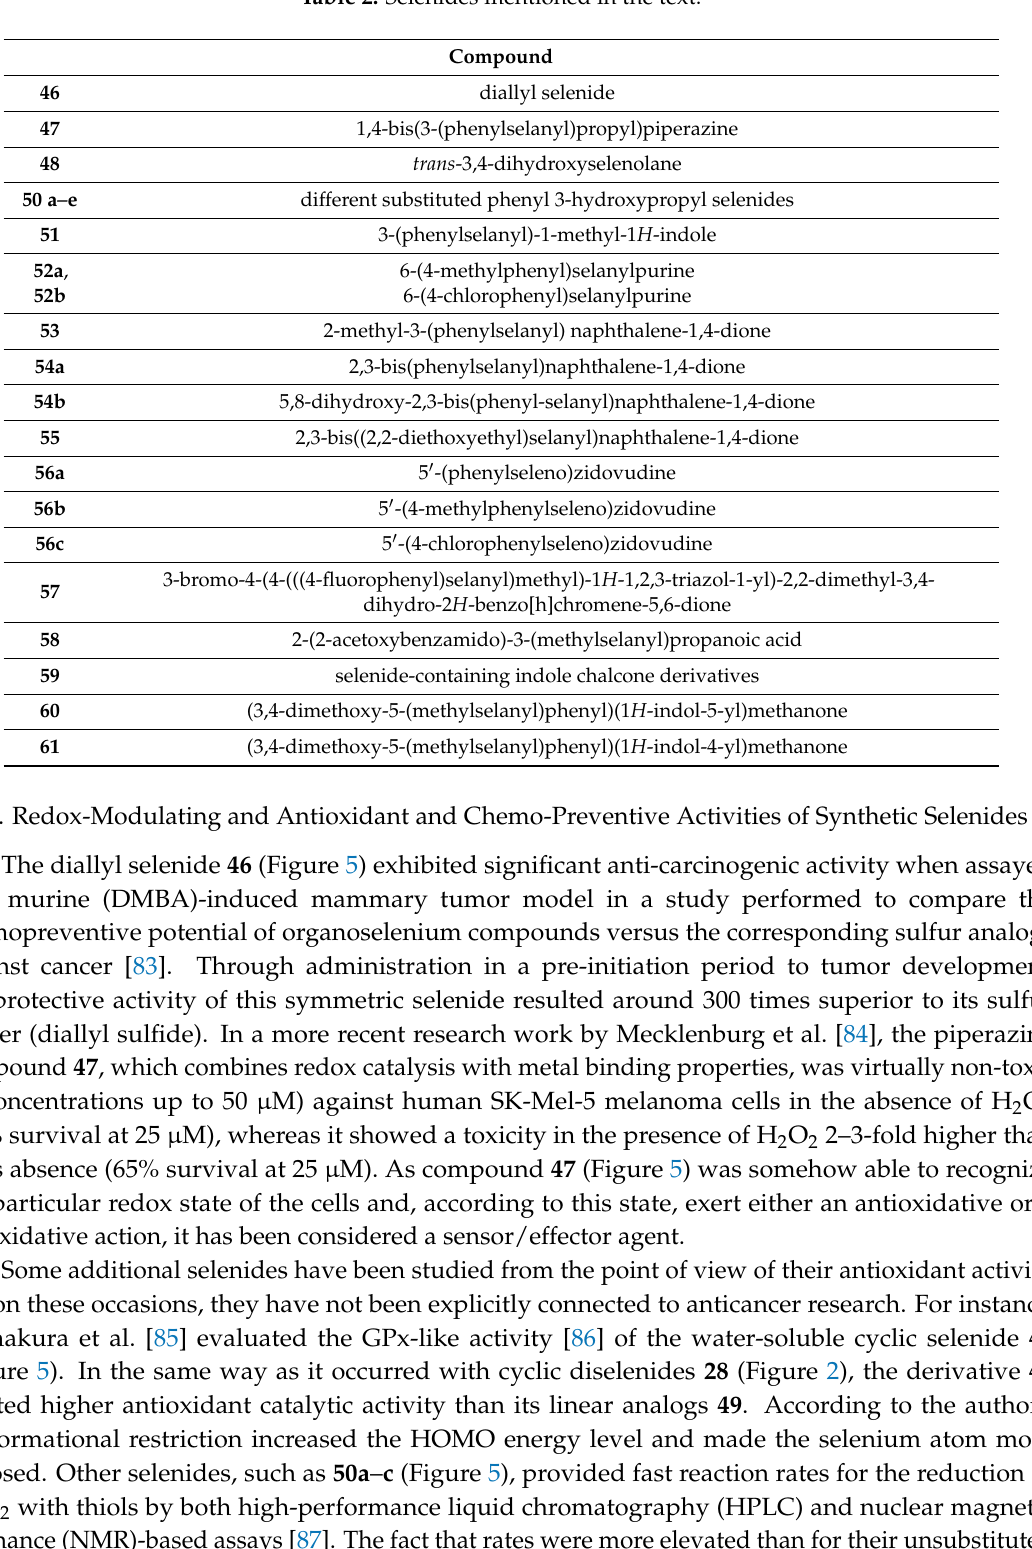
Table 2. Selenides mentioned in the